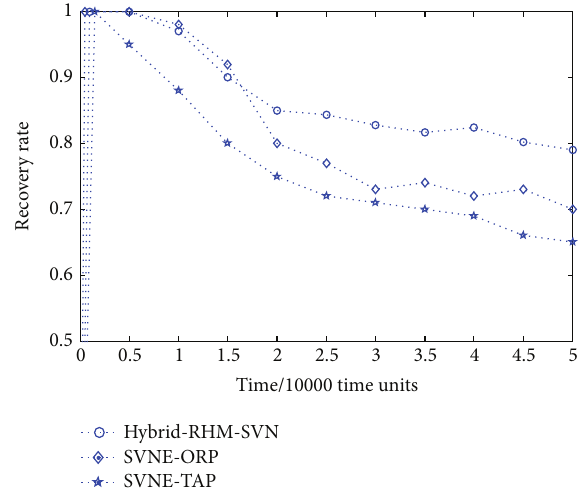
Figure 3: Recovery rate of virtual